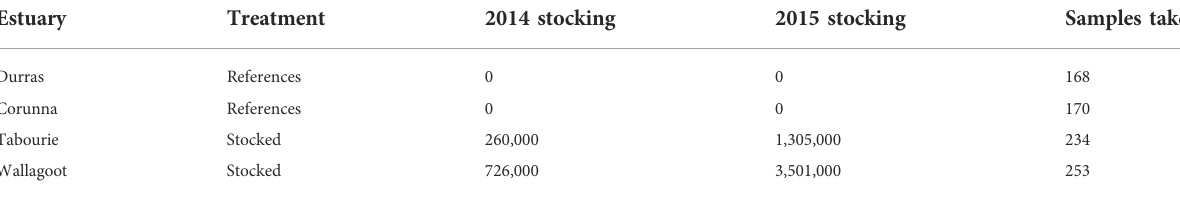
TABLE 1 The number of eastern king prawns stocked and sampled by year of released and